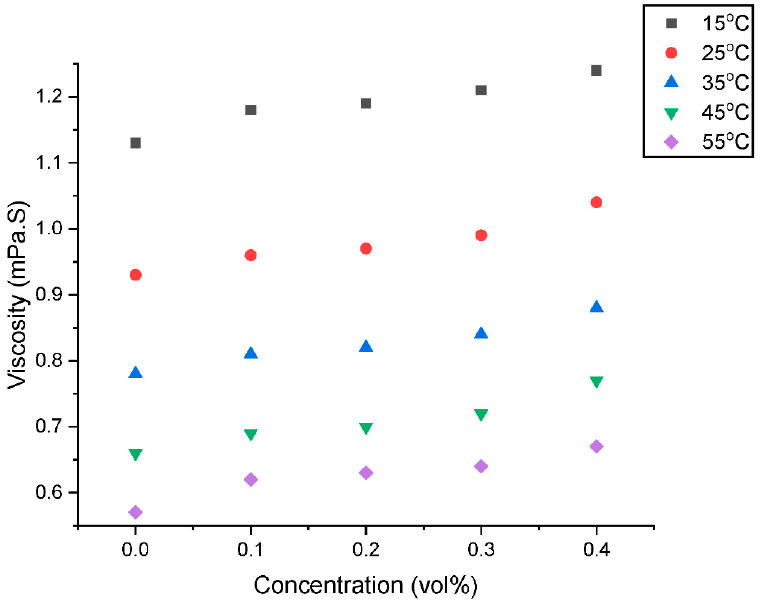
Figure 5. Influence of concentration on the viscosity of the hybrid nanofluids at various temperatures.